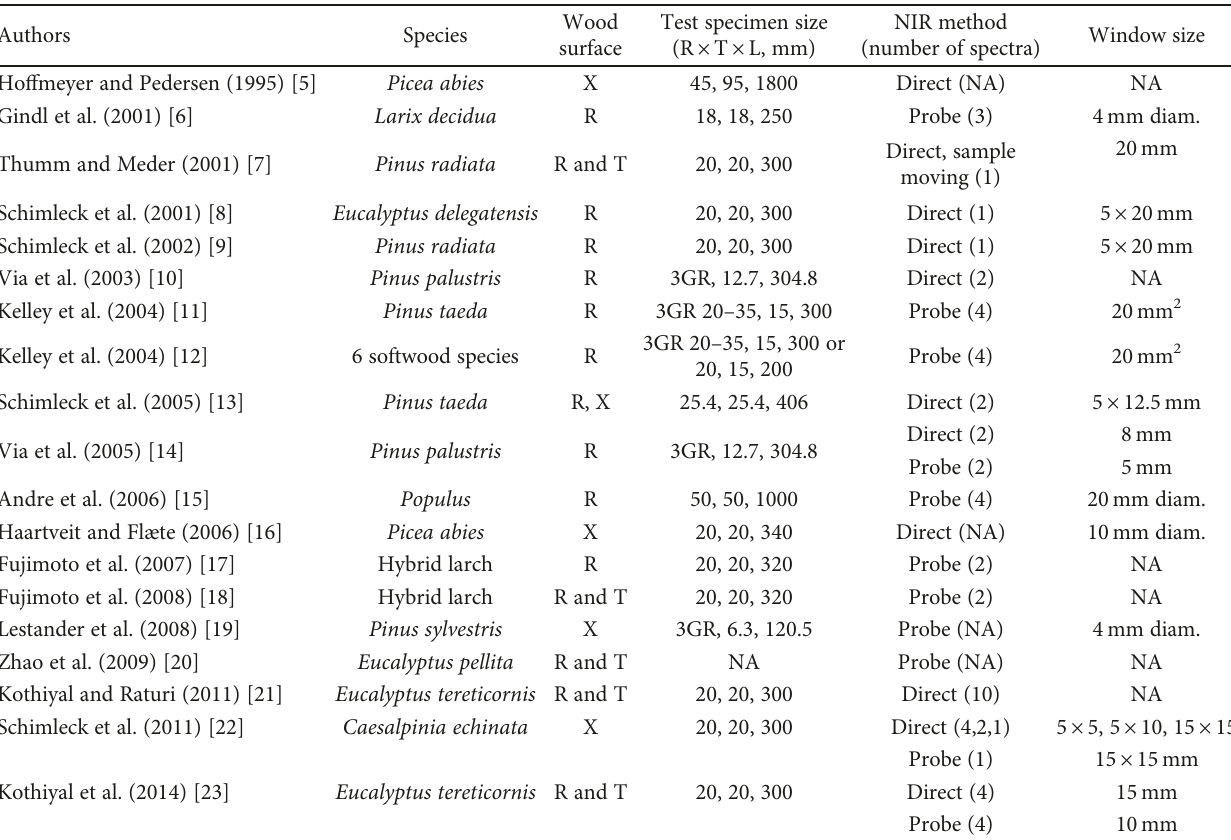
Table 1: Summary of publications that have utilized near-infrared (NIR) spectroscopy to estimate physical mechanical properties of short, clear samples. Information includes species examined, wood surface utilized, size of the short, clear sample tested, method for collecting NIR spectra, number of spectra collected, and size of the NIR beam. NA denotes that the information was not available in the publication. R =radial surface; T=tangential surface; X =transverse (or cross section) surface; GR=growth